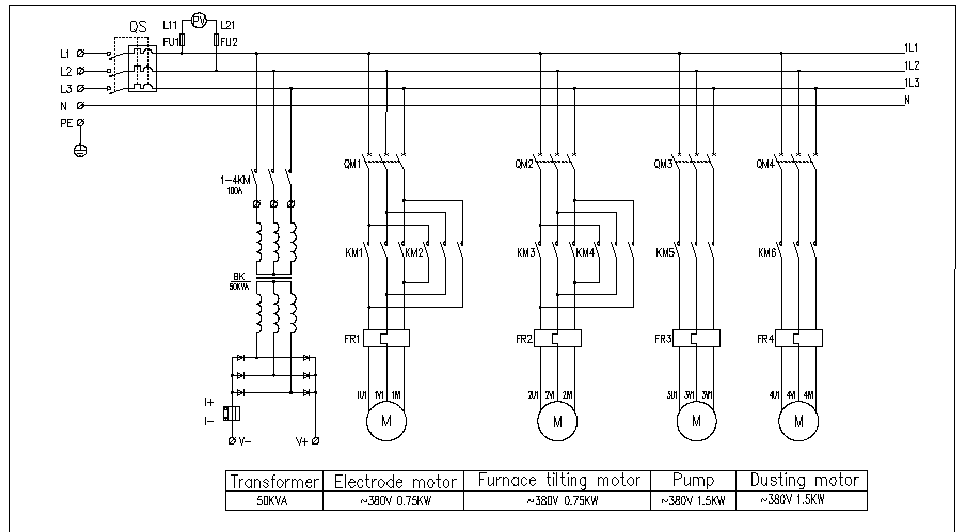
Figure 4. Schematic diagram of part of the system hardware circuit.